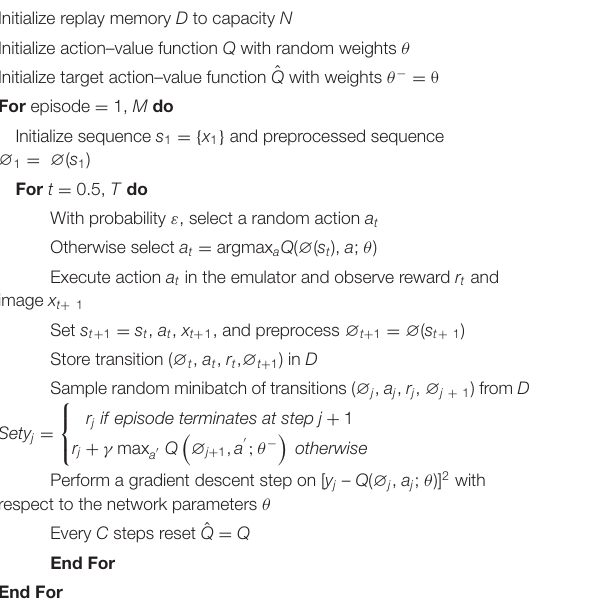
Algorithm 1: Deep Q-learning with experience replay. Initialize replay memory D to capacity